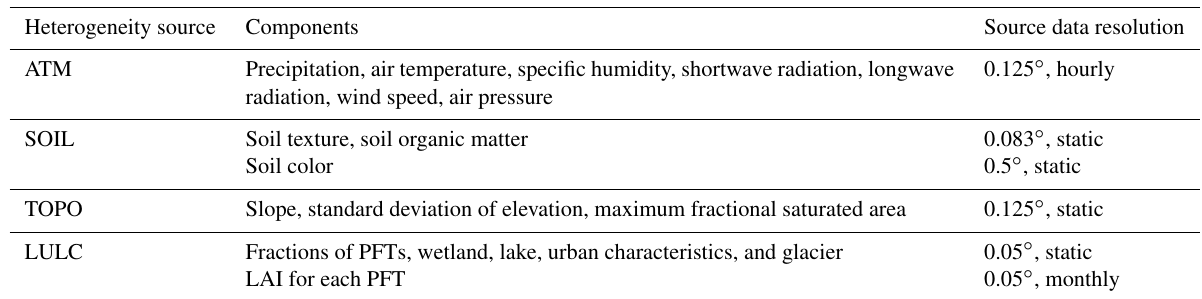
Table 1. Summary of heterogeneity sources in ELM model